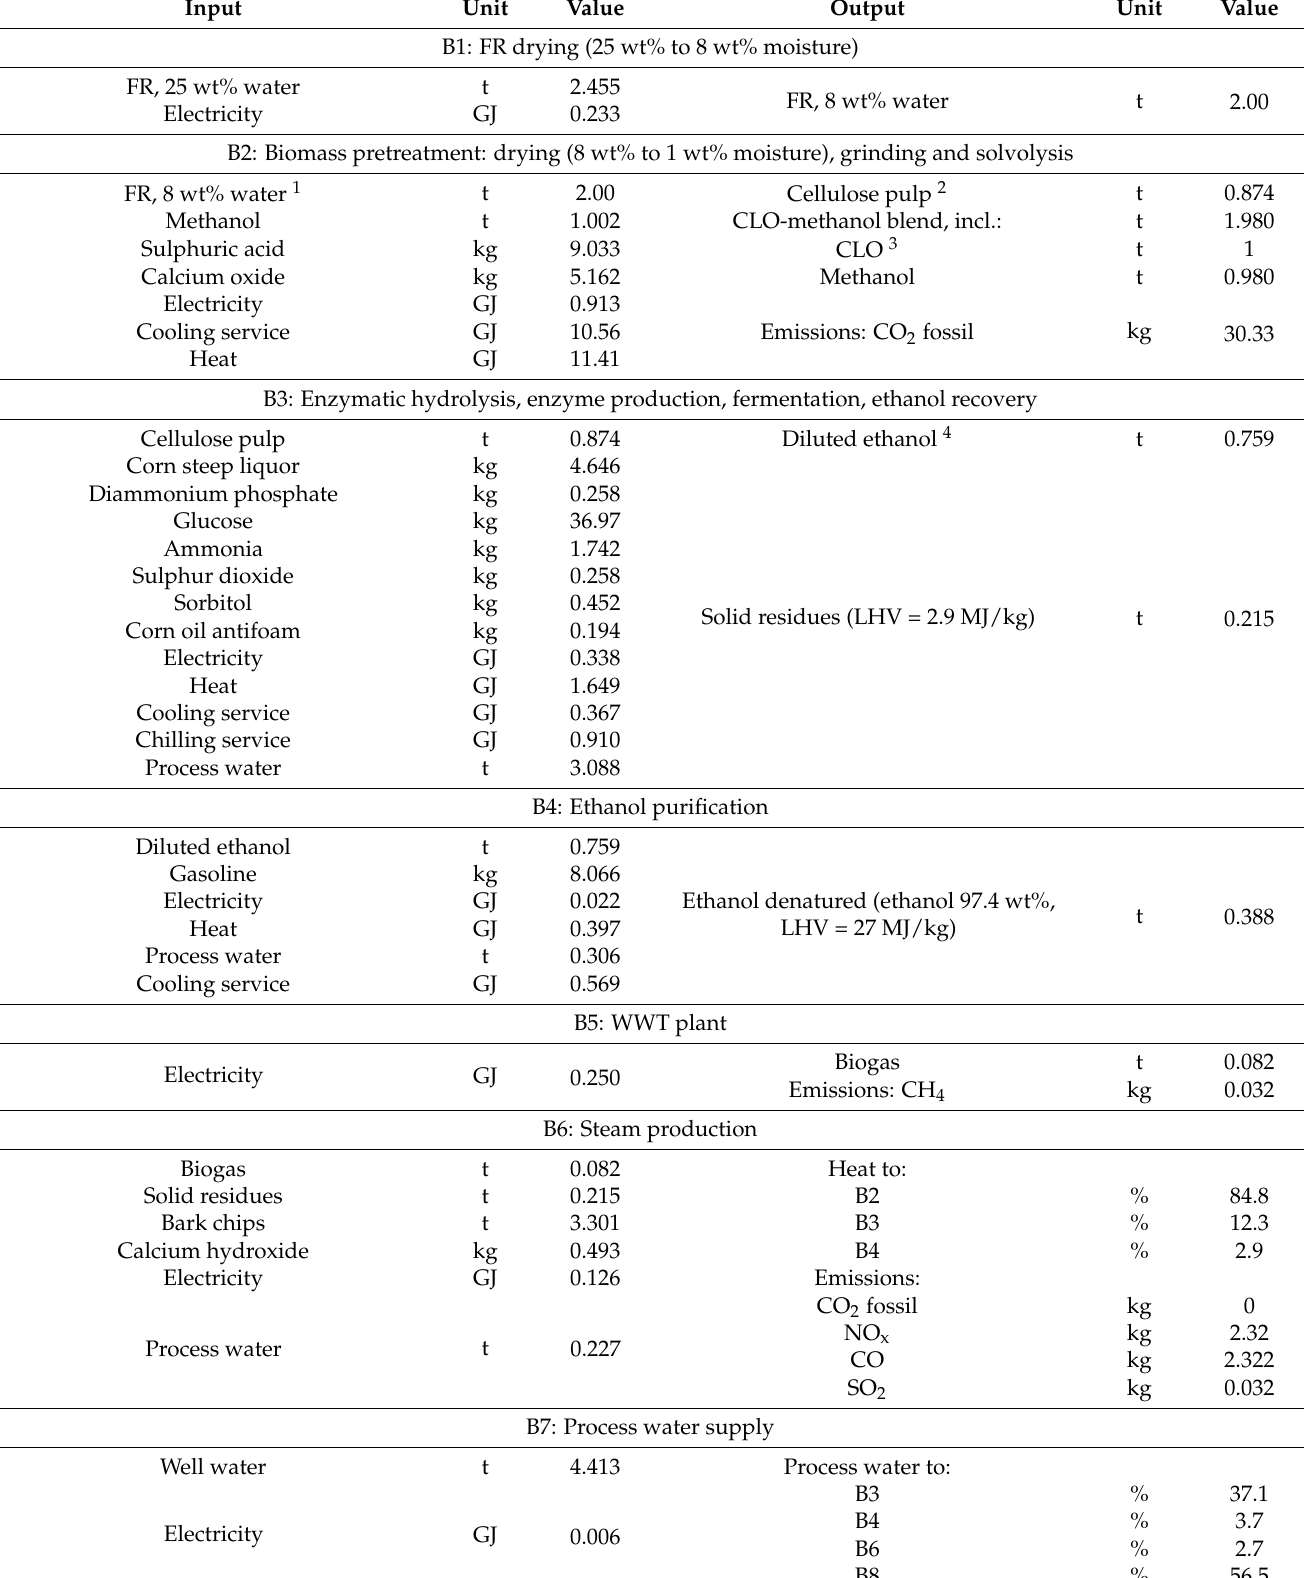
Table 1. Biorefinery inventory for the production of 1 t of